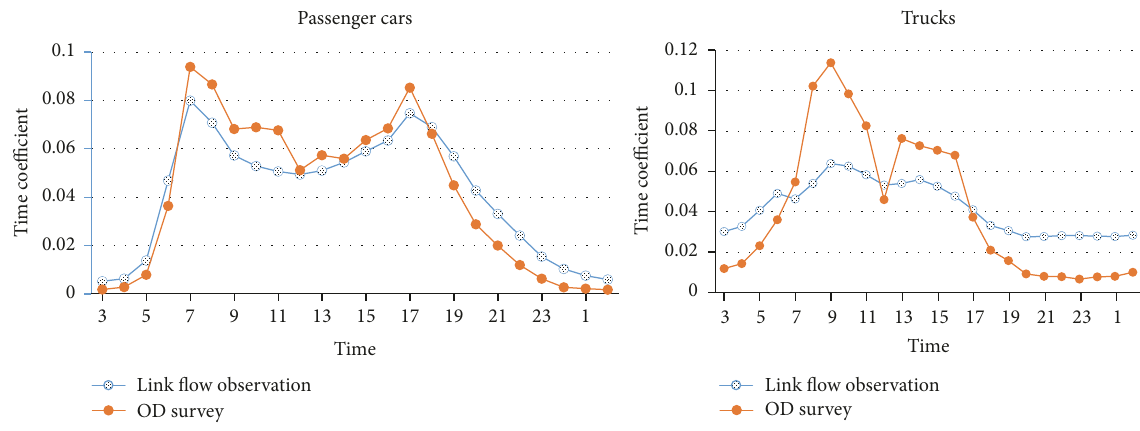
Figure 2: Hourly variation patterns by survey type and vehicle